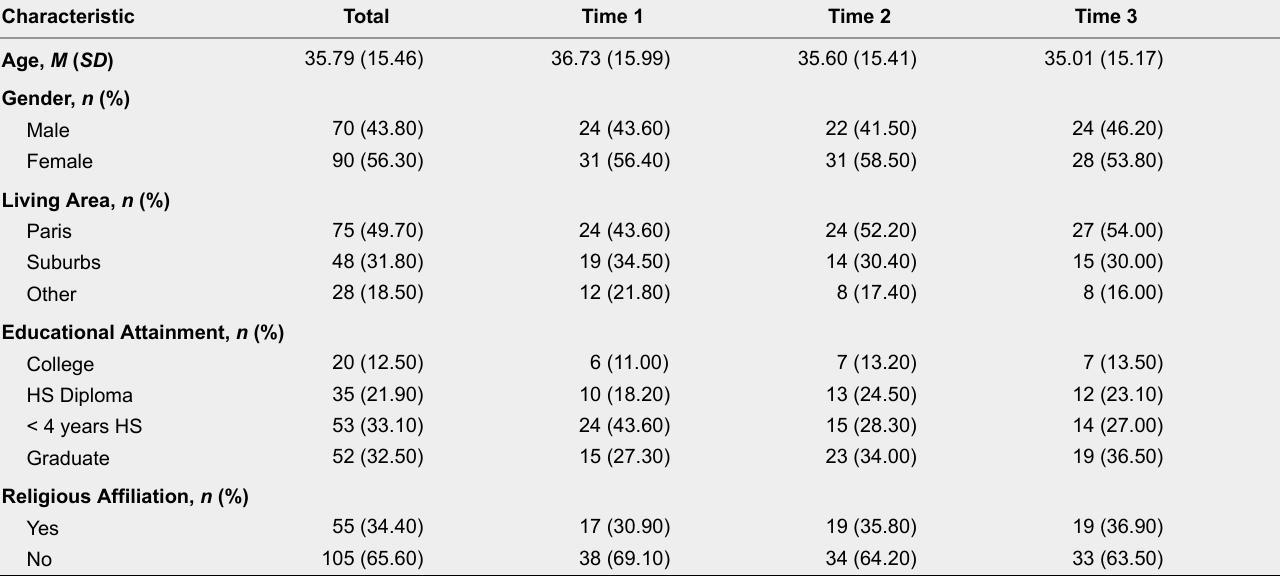
Participants’ Sociodemographic Characteristics at Three Measurement